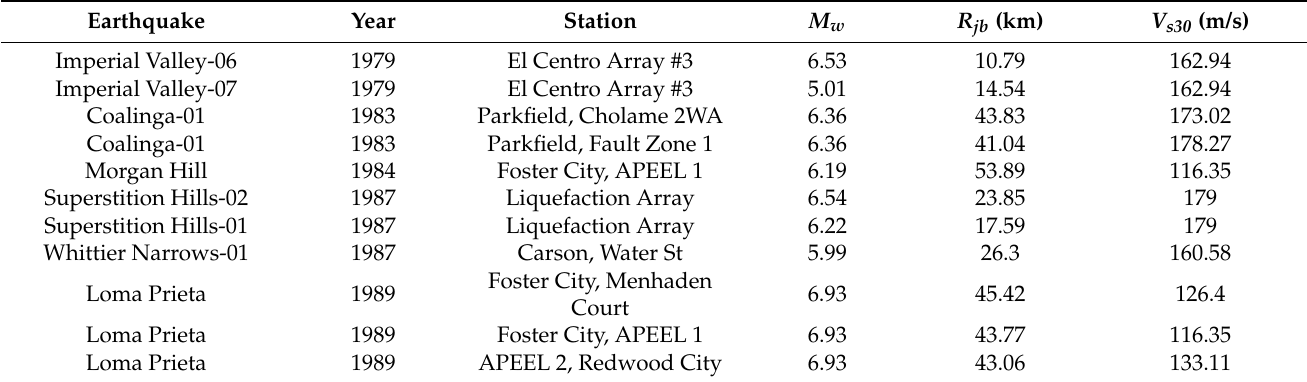
Table 3. Details of ground motions consistent with soft